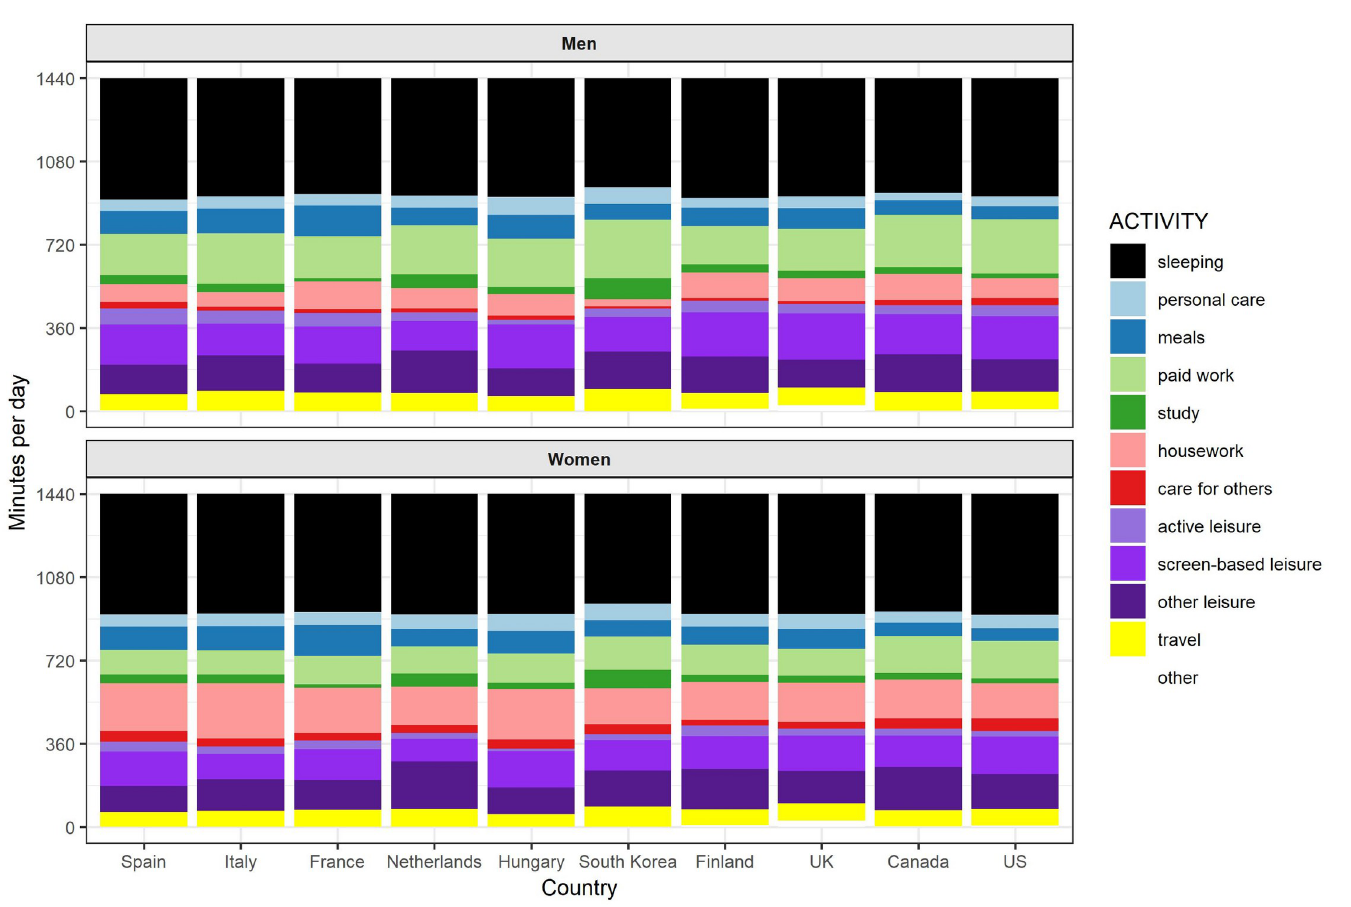
Fig 1. Average time by activity. Men and Women by country. Source: Own calculations from the Multinational Time Use Study [32]. � Activities created from the variable Main activity : Sleeping (codes 2 and 3), personal care (1 and 4), meals (5 and 6), paid work (7 to 13, except 10), study (15 to 17), housework (18 to 27), care for others (28 to 32), active leisure (42–47), screen-based leisure (59 to 61), other leisure (33–41 and 48–58) (see methods section). Other two activities include: travel (codes 62 to 68), others (10, 14 and 69). �� Estimates of the figure available in Table